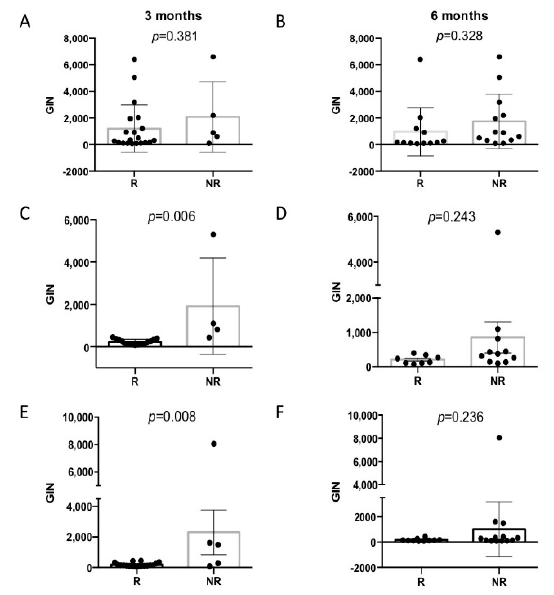
Figure 2. GIN values at T1 and T2 are associated with the 3-month clinical response. Scatter box plots of GIN values in responding patients (R) compared with nonresponding patients (NR). Clinical Response at 3 months: ( A ) (T0 or baseline), ( C ) (T1 values) and ( E ) (T2 values). Clinical response at 6 months: ( B ) (T0 or baseline), ( D ) (T1 values) and ( F ) (T2 values). The error bars reflect the standard deviations.